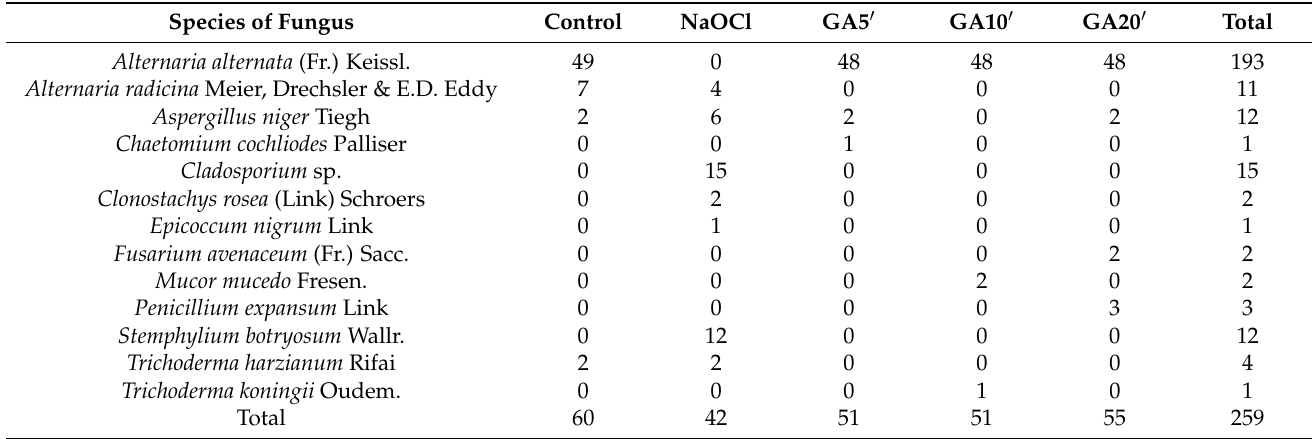
Table 6. Fungal species on Daucus